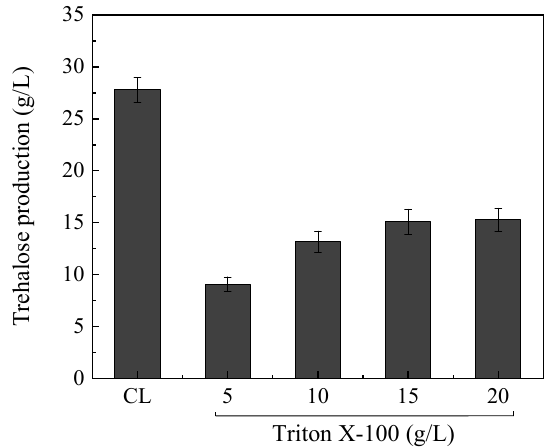
Figure 3. The effects of Triton X-100 additive amount on cell permeabilization. CL represents trehalose production by crude cell lysates. The error bars represent the standard deviation of three independent replicates.